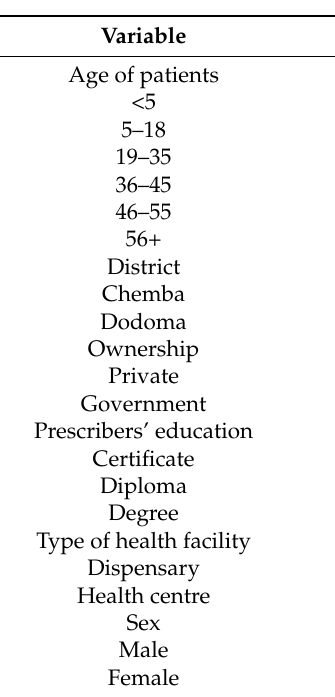
Table 1. Demographic